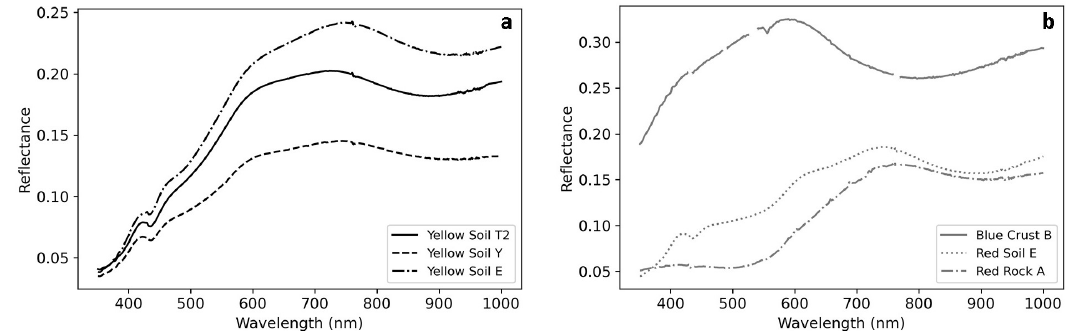
Figure 11. Spectral profile results of the October 2020 ground survey. ( a ) Yellow soil spectral profiles at Y, T2, and E. ( b ) Spectral profiles for EMS at B, and red soils at E and A. Each field spectroscopy sample was taken with the field portable remote sensing spectroradiometer. See Figure 10 for